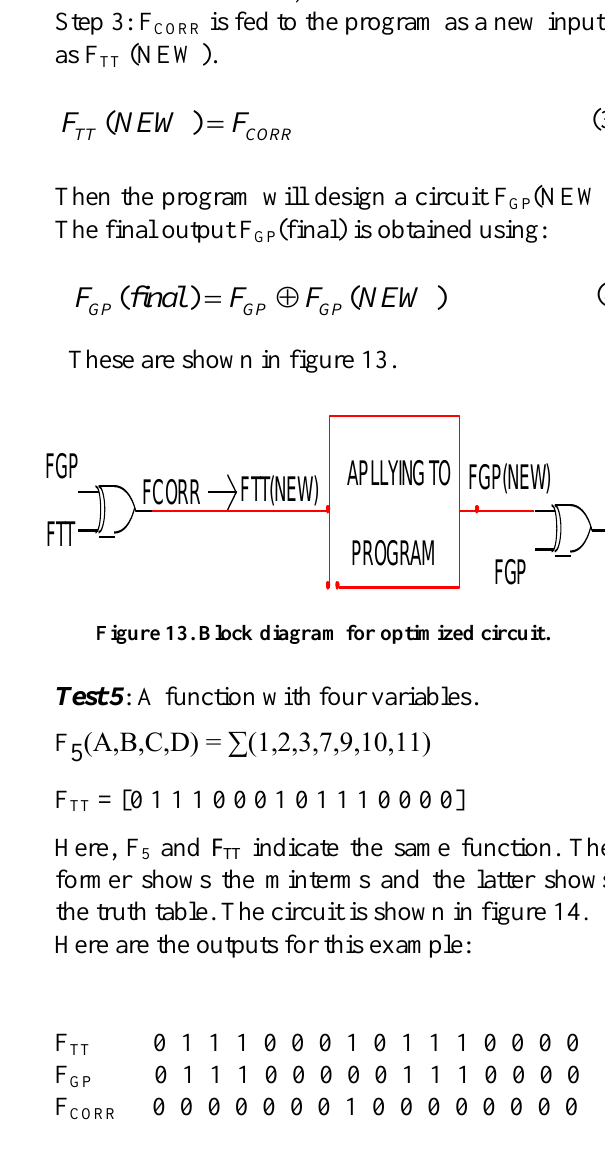
Figure 10. Circuit for F 4 .